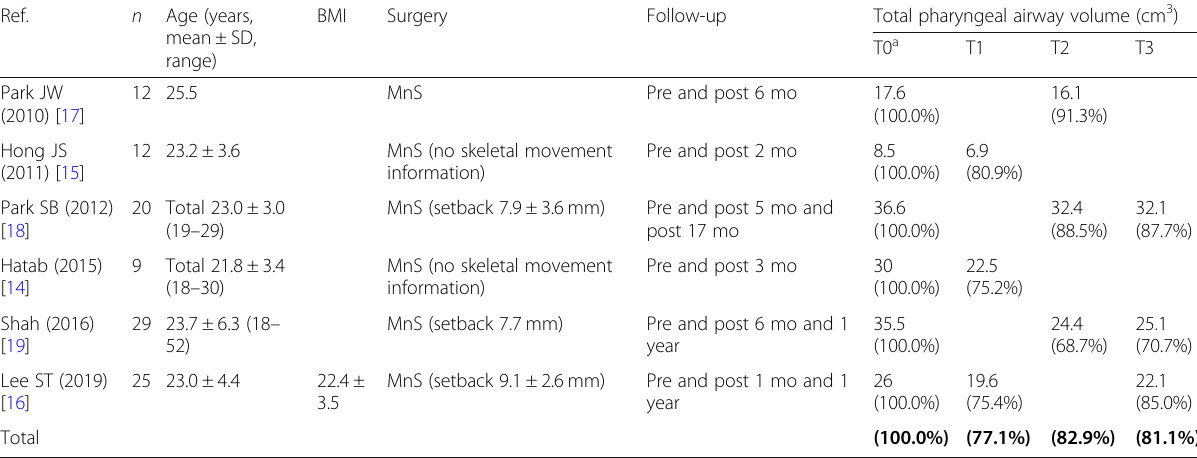
Table 1 Changes in the total pharyngeal airway volume after isolated mandibular setback surgery for mandibular prognathism